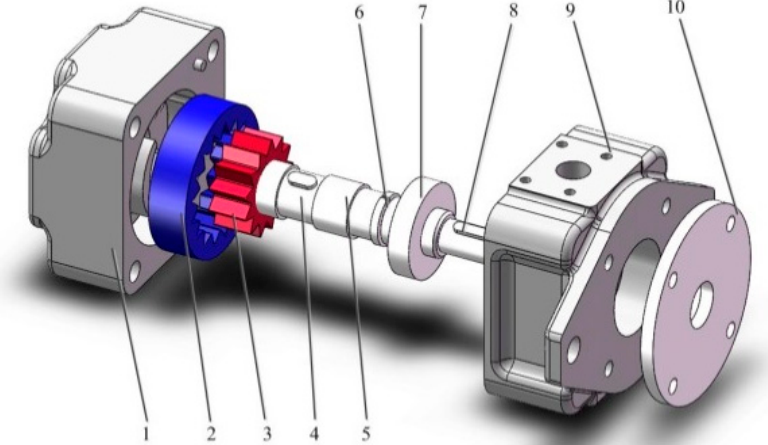
Figure 9. Three-dimensional structure diagram of straight line conjugate internal meshing gear